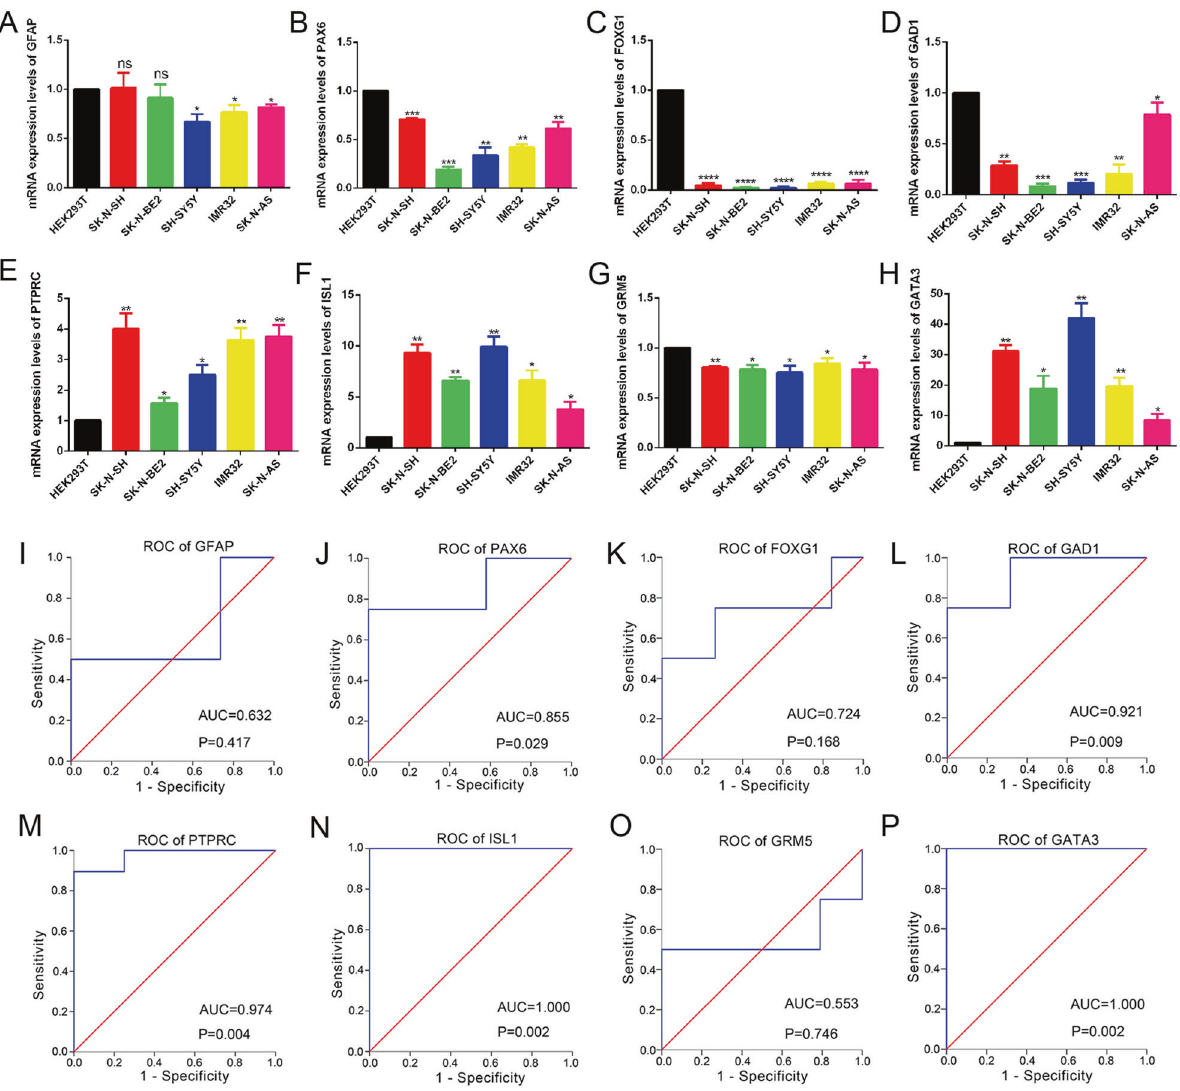
Fig. 2 The eight hub genes of identi fi cation. A The mRNA expression levels of the top eight hub genes were determined in HEK293T cells and 5 NB cell lines by qRT-PCR. B Validation of ROC results of the 8 hub genes in NB based on GSE54720 (* P < 0.05, ** P < 0.01, *** P < 0.001, **** P <